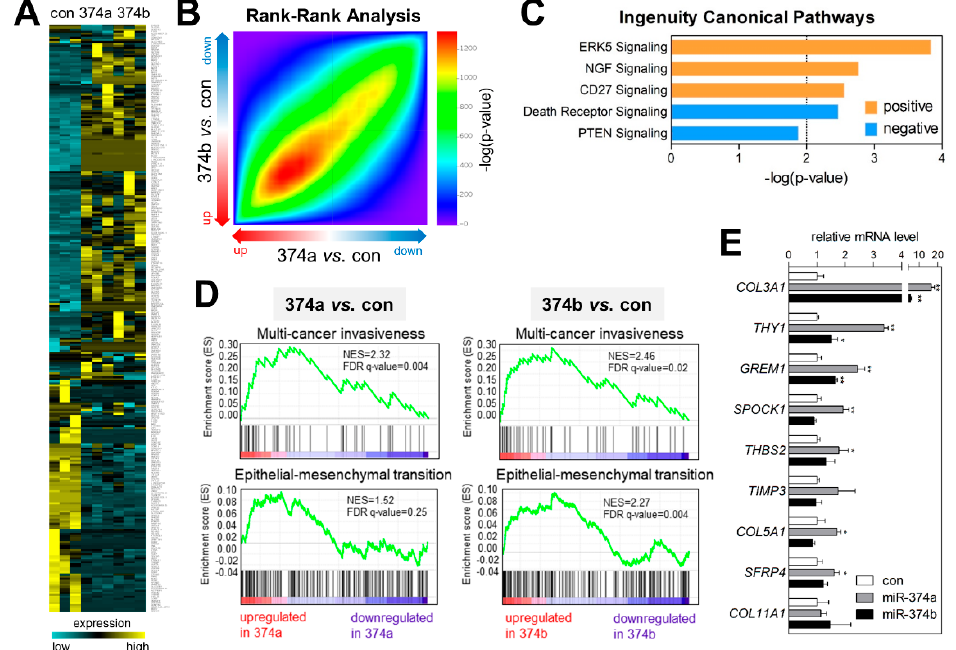
Figure 5. miR-374a and miR-374b induce gene signatures related to EMT and invasiveness. ( A ) Heatmap showing RNA-sequencing data obtained from miR-374a / b-overexpressing or control A549 cells. Commonly upregulated or downregulated genes in both miR-374a- and miR-374b-overexpressing cells as compared with controls are presented in the heatmap ( | fold change | ≥ 2, adjusted p ≤ 0.05, and average Transcripts Per Million ≥ 1). Yellow: increased expression; blue: decreased expression. ( B ) Heatmap showing rank–rank hypergeometric overlap analysis of two profiling datasets (miR-374a vs. control and miR-374b vs. control). ( C ) IPA of genes di ff erentially regulated by miR-374a / b. The top 500 commonly upregulated or downregulated genes in both profiles (a total of 1000 genes) were analyzed using the IPA tool to estimate enriched canonical pathways. The top five significantly enriched pathways are presented in the graph. ( D ) GSEA of di ff erentially expressed genes in miR-374a- or miR-374b-overexpressing cells as compared with controls. The gene signatures “multi-cancer invasiveness” and “epithelial-mesenchymal transition” were enriched in both profiles. ( E ) qRT-PCR of EMT and invasiveness signature genes in miR-374-mimic transfected cells. A549 cells were transiently transfected with miR-374a or miR-374b mimics, and expression levels of the signature genes were measured by qRT-PCR. Expression levels were normalized to that of RPL32 . Relative values to those in A549 cells transfected with negative control (set to 1.0) are presented. Data represent the mean + SD ( n = 3). * p < 0.05, ** p < 0.01; two-tailed Student’s t